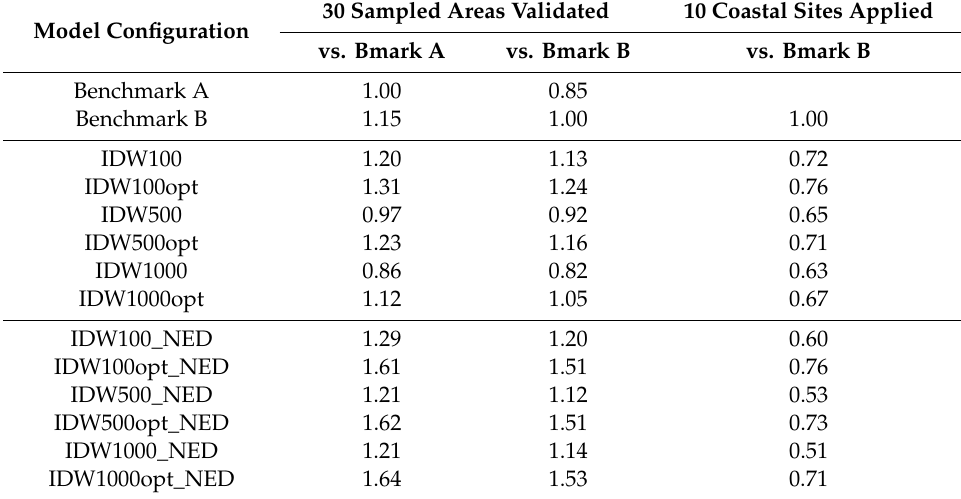
Table 4. S-ratio summary statistics of 30 sampled validation sites and 10 selected coastal